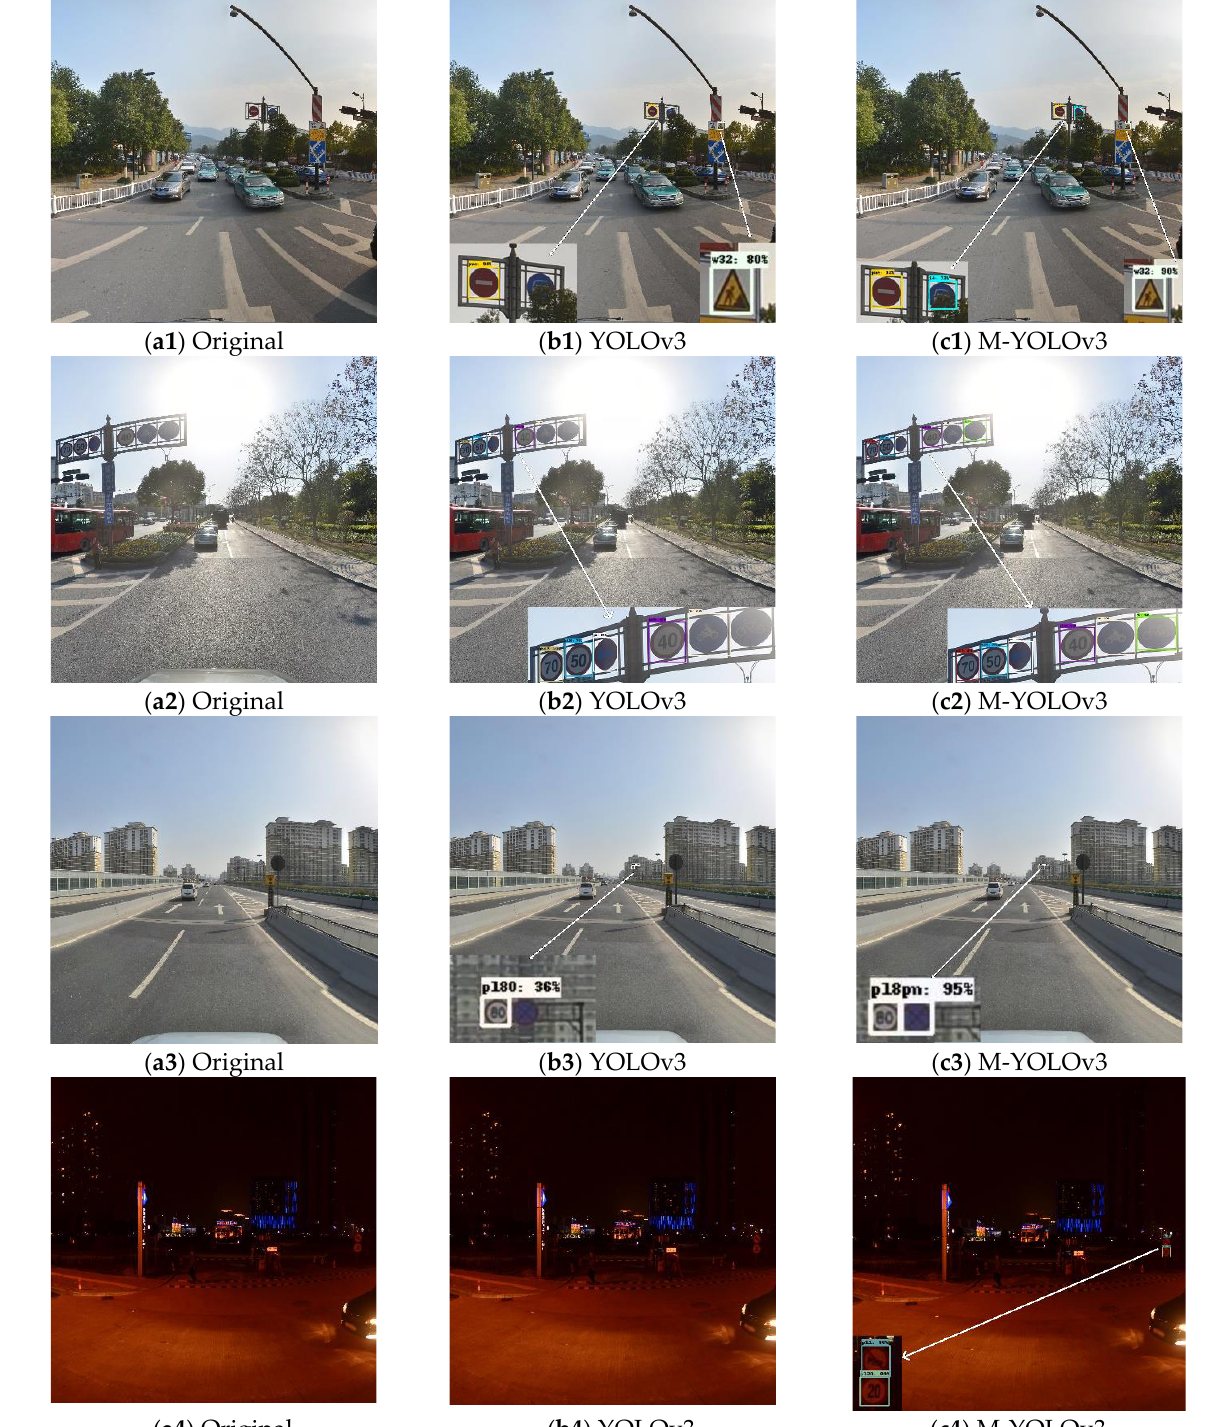
Figure 14. Comparison of the recognition effect of traffic signs under special environments.